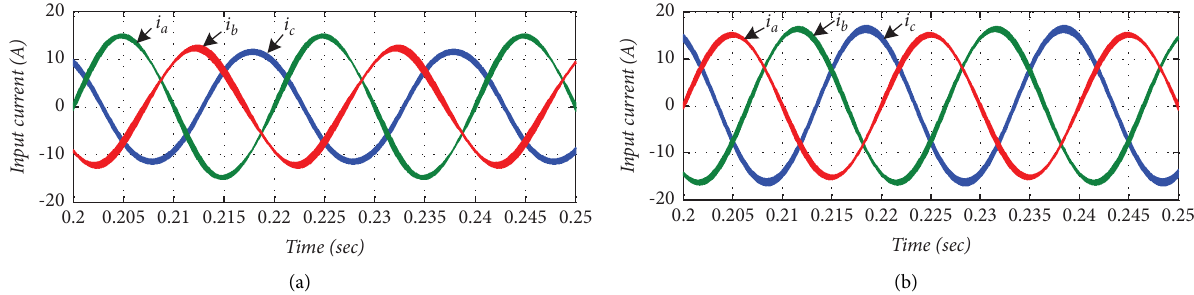
Figure 8: Tree-phase input current under unbalanced grid voltage with a diferent controller; (a) proposed and (b) conventional.